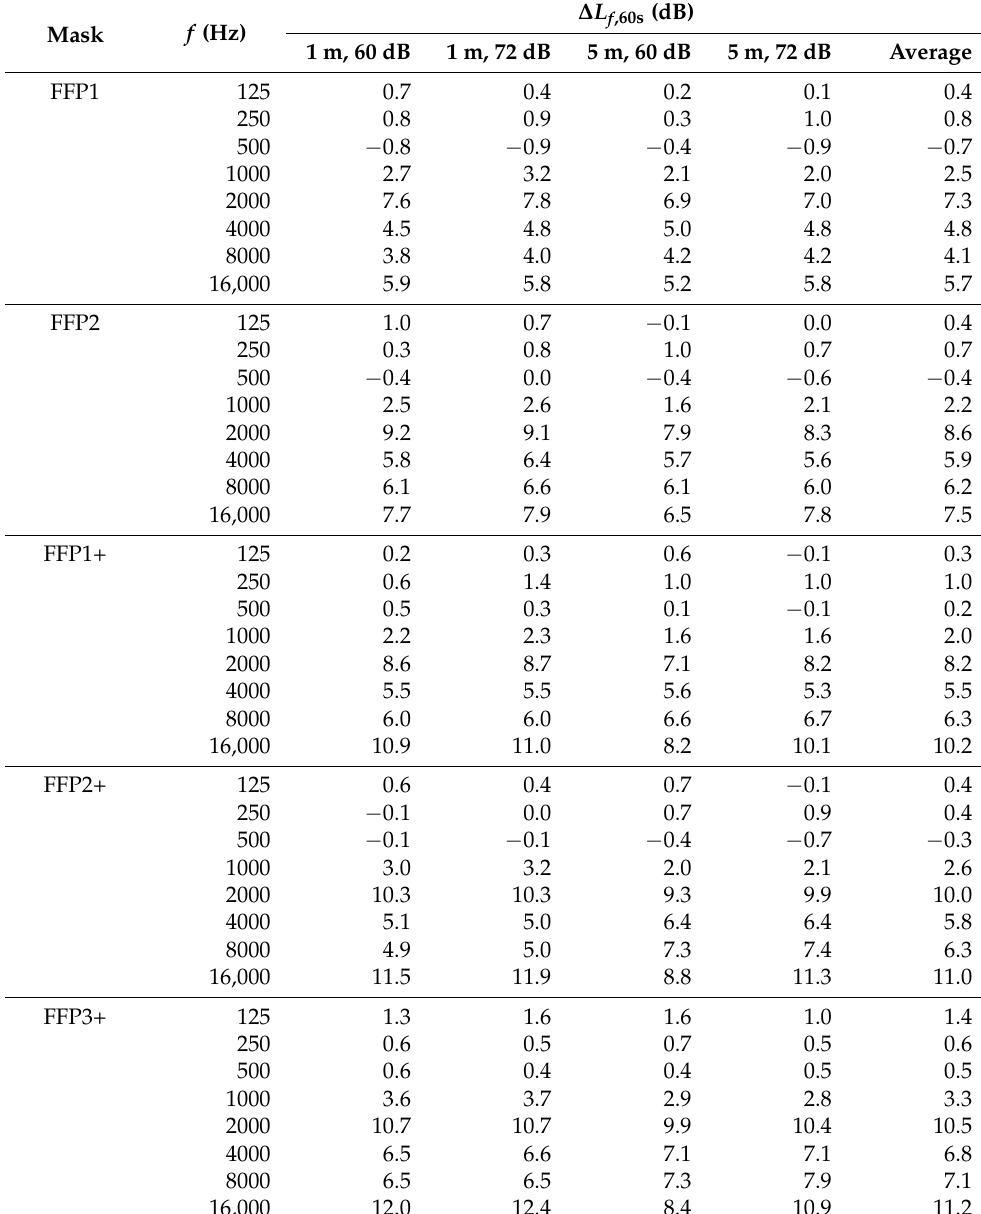
Table 2. Attenuation of sound in octave bands with center frequency f by the five FFPs, ∆ L f ,60s , measured at two speaker–microphone distances and two white noise decibel levels, and the respective averaged